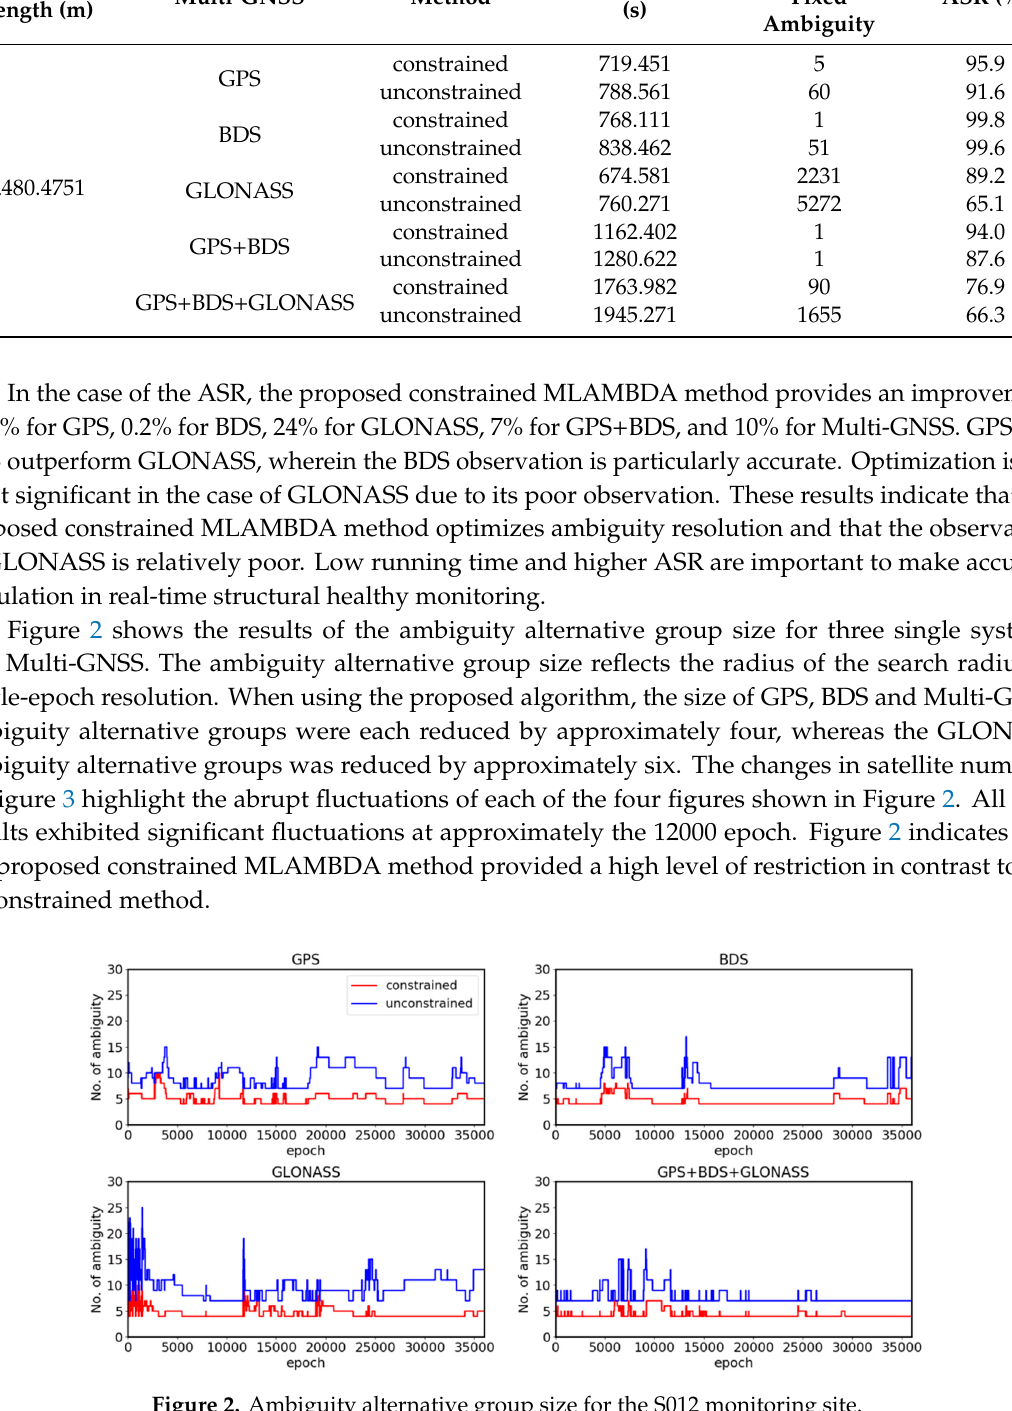
Figure 2. Ambiguity alternative group size for the S012 monitoring site.